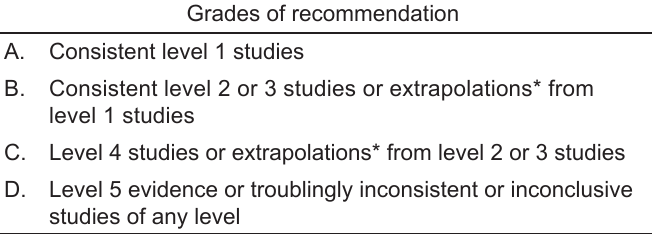
Table 2. Oxford Centre for Evidence-Based Medicine grades of recommendation.